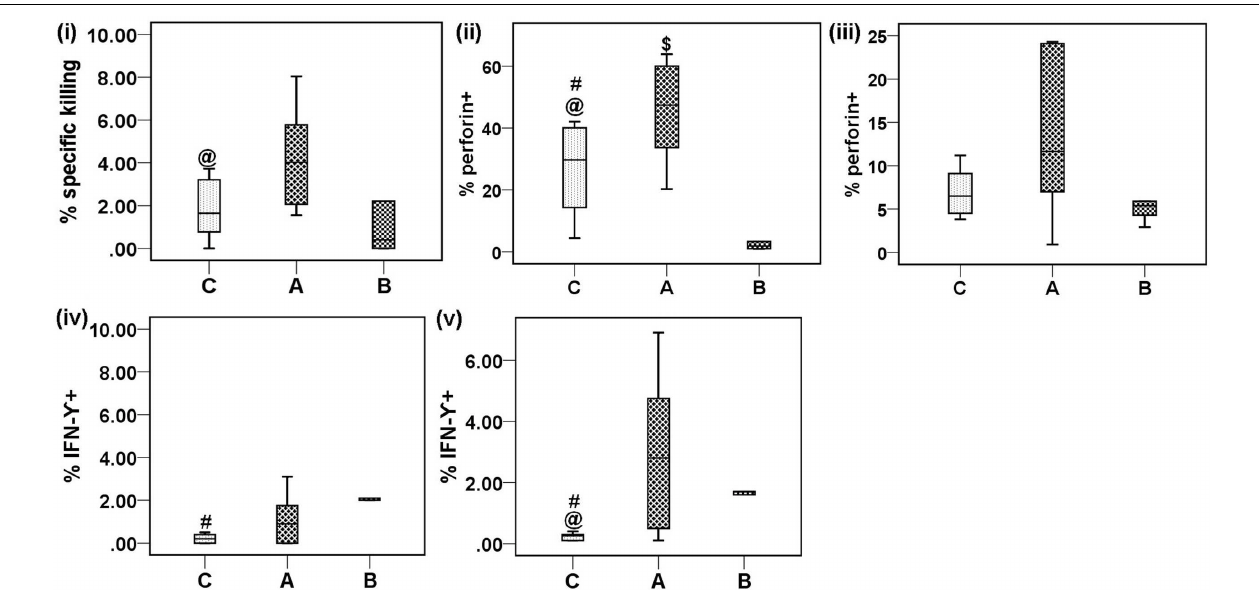
FIGURE 4 | Cytotoxic potential, intracellular perforin and cytokine expression of NK/NKT-like cells against target cells (K562). PBMCs (effector) were isolated from the whole blood of eight control subjects, eight acute patients, and six convalescent patients. PBMCs were co-cultured with K562 cells (target) at an effector/target ratio of 10:1 for 6h. Box plots show, (i) % specific killing against target cells, (ii) perforin expression by NK cells, (iii) perforin expression by NKT-like cells, (iv) IFN- γ by NK cells, and (v) IFN- γ by NKT-like cells. Mann–Whitney U-test/Kolmogorov–Smirnov test was used for intergroup comparison. p < 0 . 05 is considered